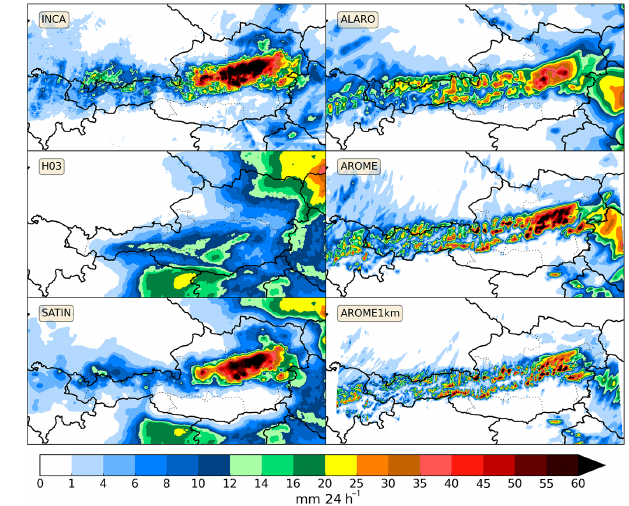
Figure 12. 24h precipitation sum from different models for 15 May 2014.